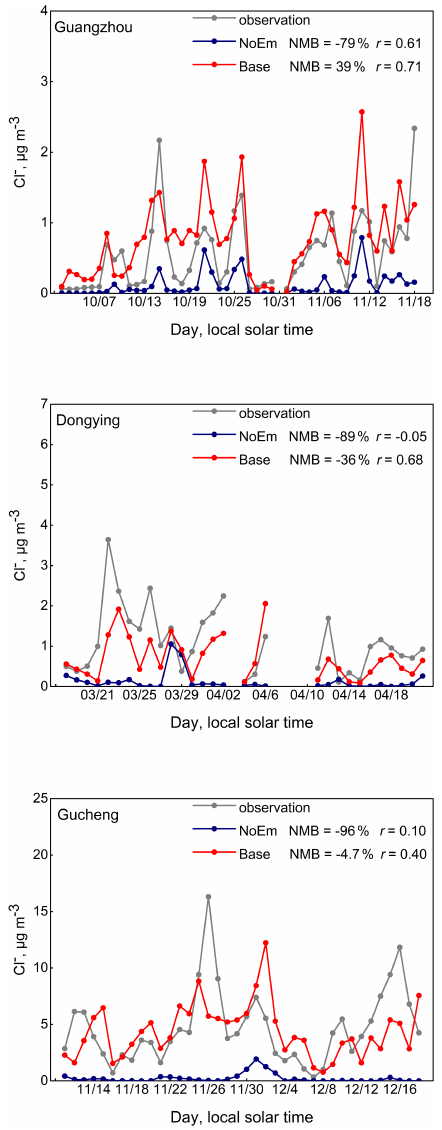
Figure 2. Time series of simulated and observed particulate Cl − concentrations at the Guangzhou, Dongying, and Gucheng